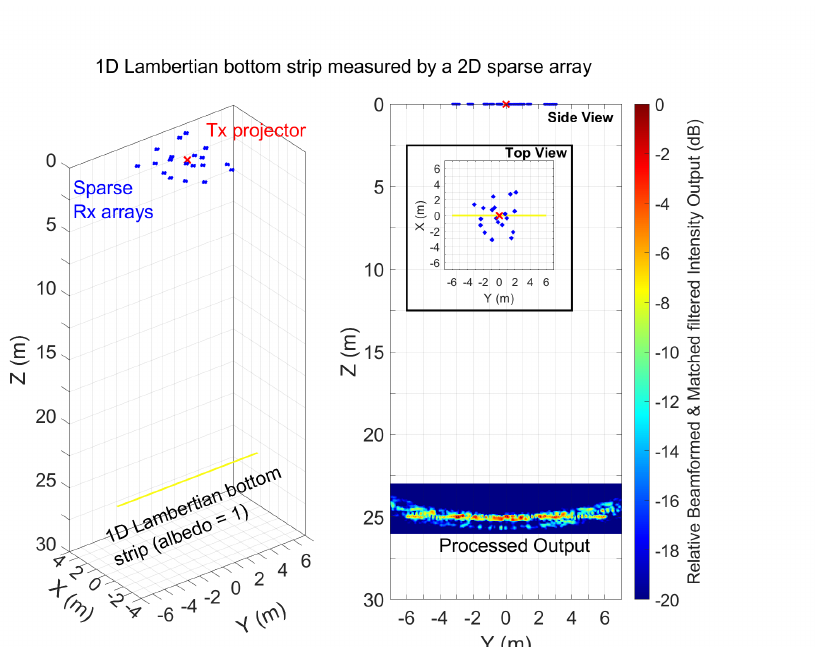
Figure A3. Simulated imaging with a sparse array. The environmental configuration and transmit waveform are the same as those in Figure A2. The geometry of the sparse receive array and the transmitter is shown. The matched filtered and beamforming scattered output energy is spread around the seafloor region because of the sidelobes. Note that a 1D bottom strip models a fan-shaped transmit beam that is narrow in the x direction and wide in the y direction.